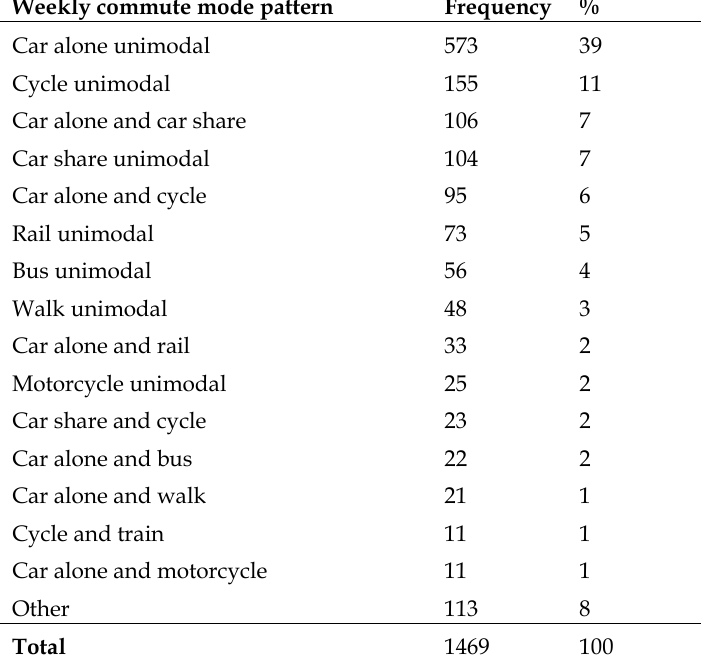
Table 7. Weekly commute mode pattern groups at wave